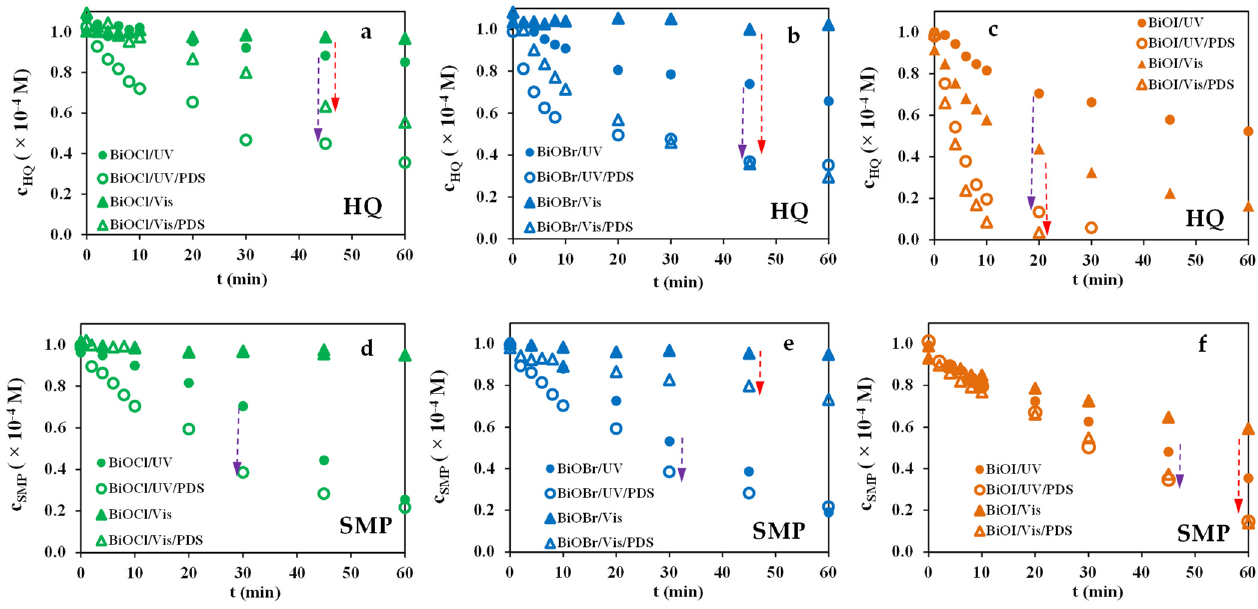
Figure 7. The effect of 1.0 × 10 − 3 M PDS on the transformation of HQ ( a – c ) and SMP ( d – f ) in UV and Vis irradiated, aerated BiOCl ( a , d ), BiOBr ( b , e ), and BiOI ( c , f ) suspensions. (The narrows show the effect of PDS (purple: UV; red: Vis).